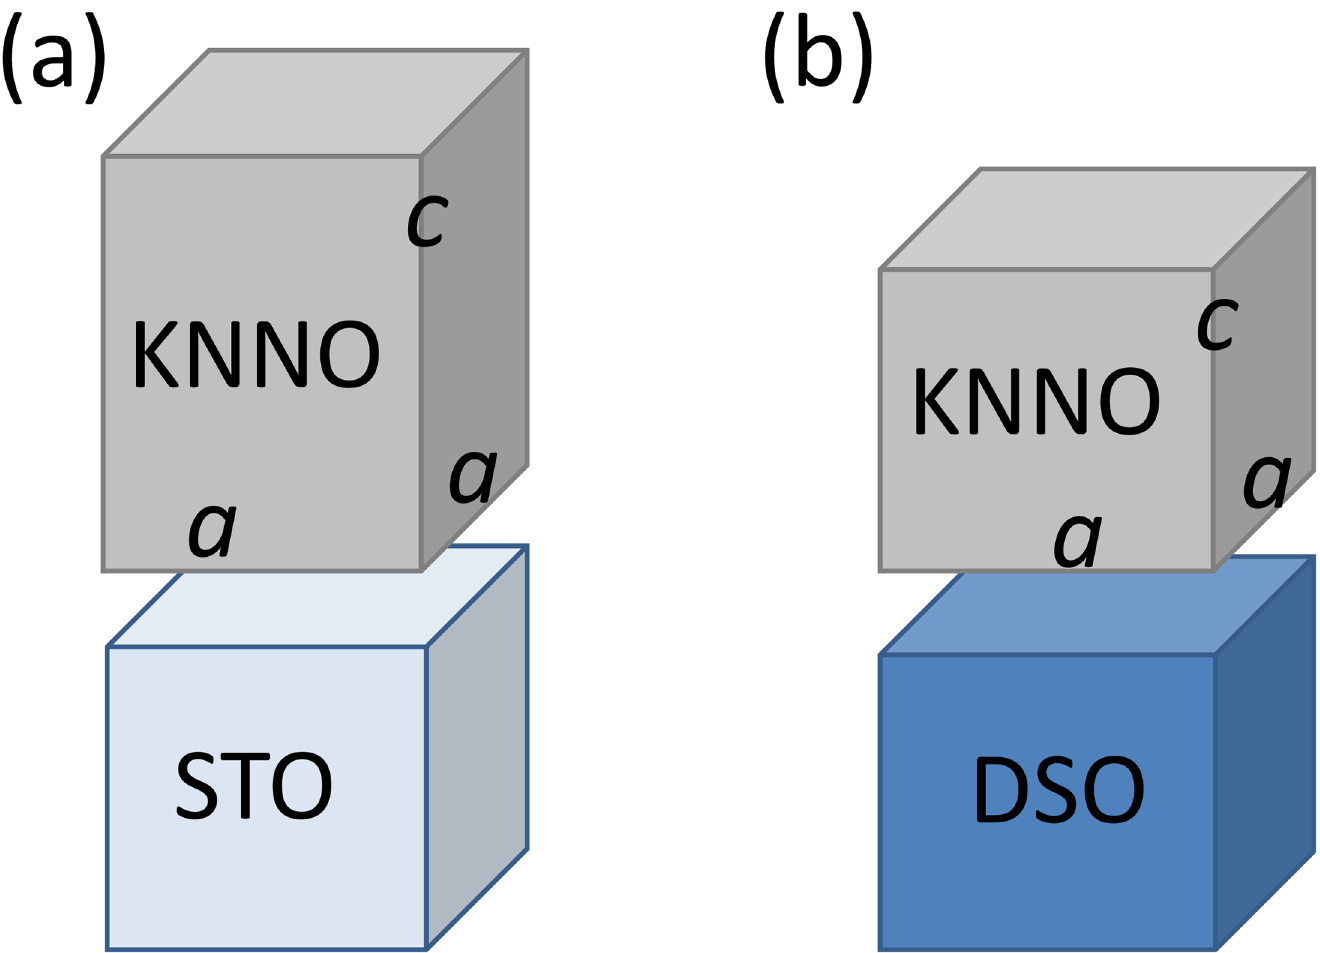
Fig 3. Schematic pesentation of (a) tetragonal and (b) pseudo-cubic unit cells in the cube-on-cube-type epitaxial KNNO films on (a) STO and (b) DSO substrates.